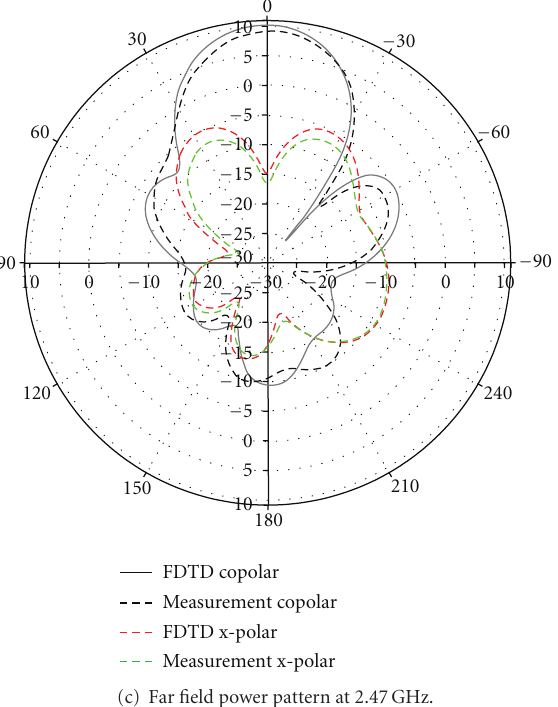
Figure 16: E-plane far field power pattern of the patch antenna array at 2.41 GHz, 2.44 GHz, and 2.47 GHz.